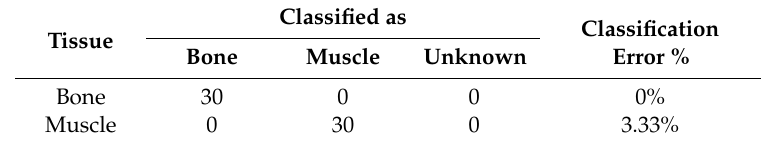
Table 3. Confusion matrix for the bone and muscle types during the laser ablation at 7 J pulse